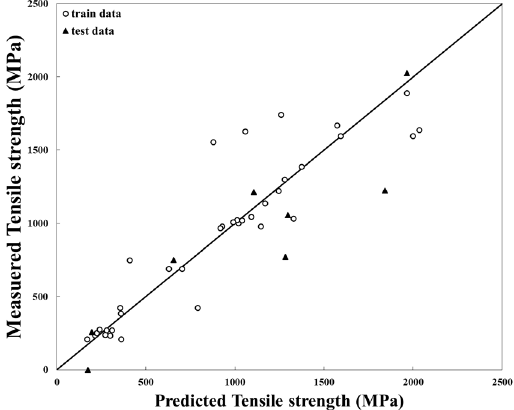
Figure 4. Accuracy of a lasso model trained with elemental mole fraction and process data.